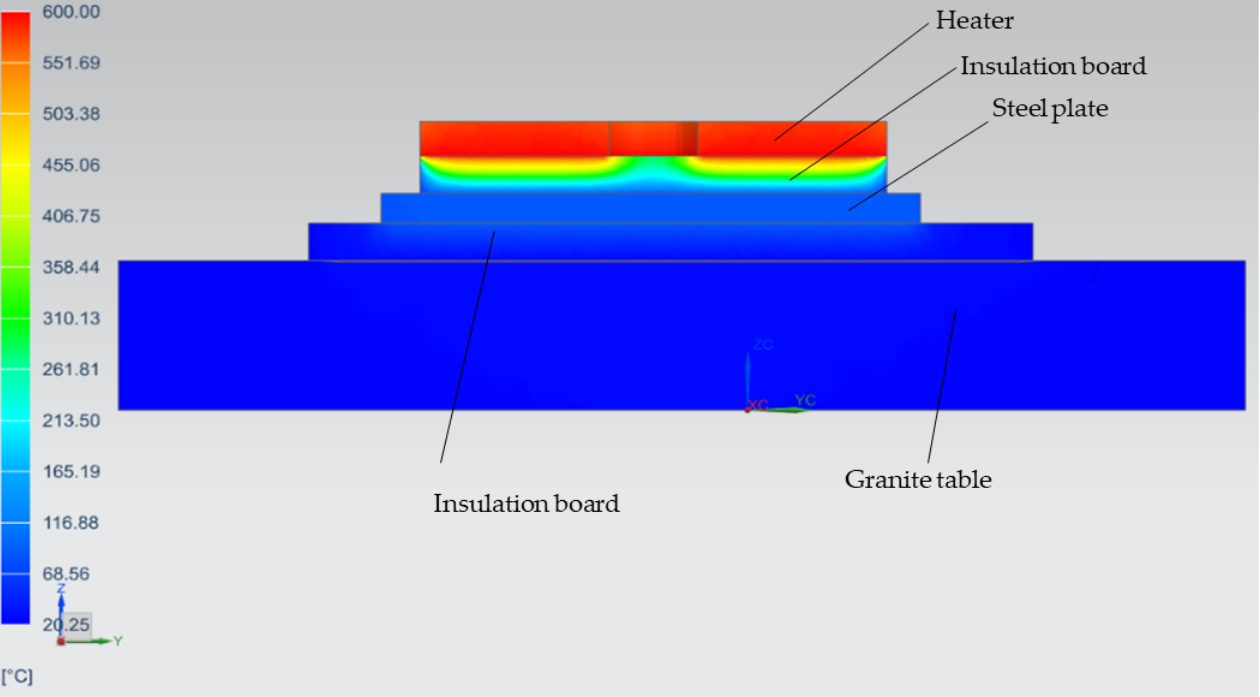
Figure 20. Validation model simulation (FEA) results.